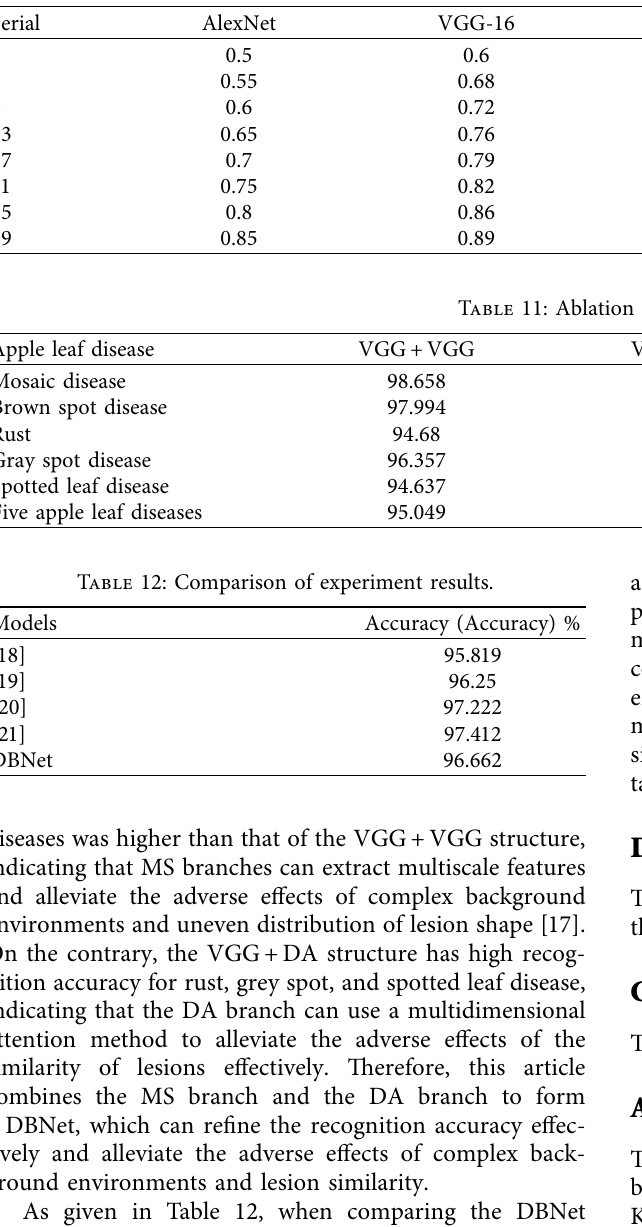
Table 10: Comparison of accuracy changes of diferent network